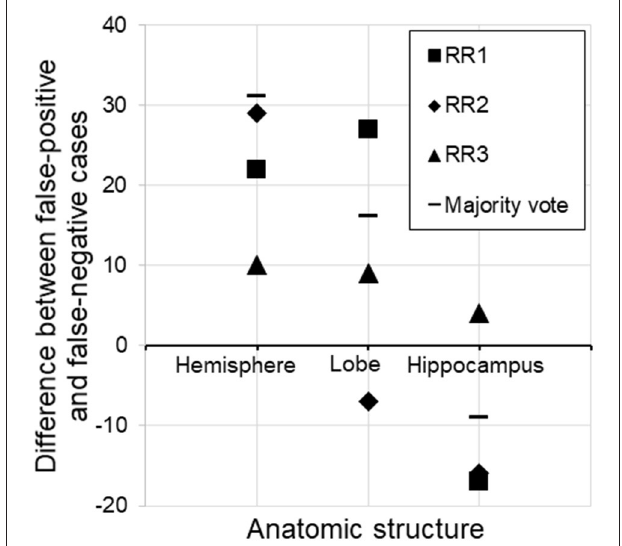
FIGURE 4 | Subtraction of false-negative cases from false-positive cases for three different structures. For the hemisphere, there were more false-positive than false-negative cases, suggesting that the threshold (z-score < -2.0) was too low (too close to zero and sentences were triggered too often). On the other hand, the same threshold was too relaxed for the hippocampus, assuming the radiologists’ judgment to be the gold standard. RR, radiologic